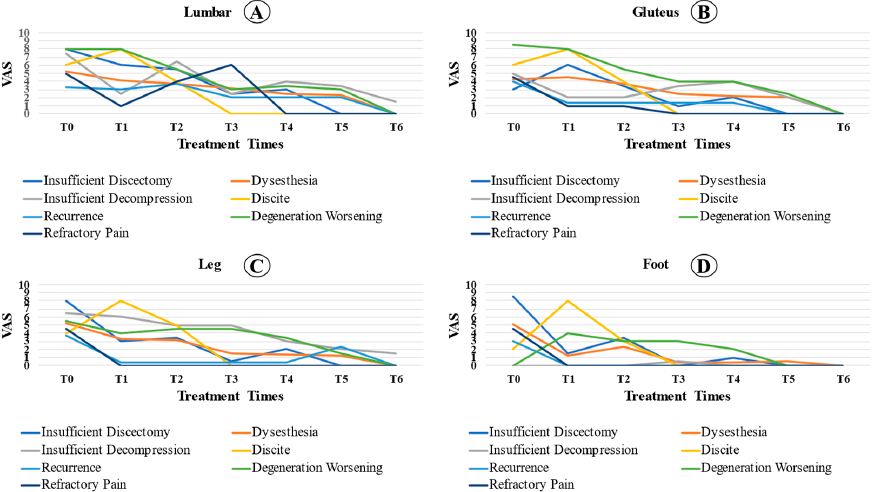
Figure 3. Comparison of the complicated patient’s VAS between locations (( A ): lumbar; ( B ): gluteus; ( C ): leg; ( D ): foot) over the preoperative time (T0), 2 days (T1), 1 month (T2), 3 months (T3), 6 months (T4), 12 months (T5), and 24 months (T6) postoperative period among cases with complications.